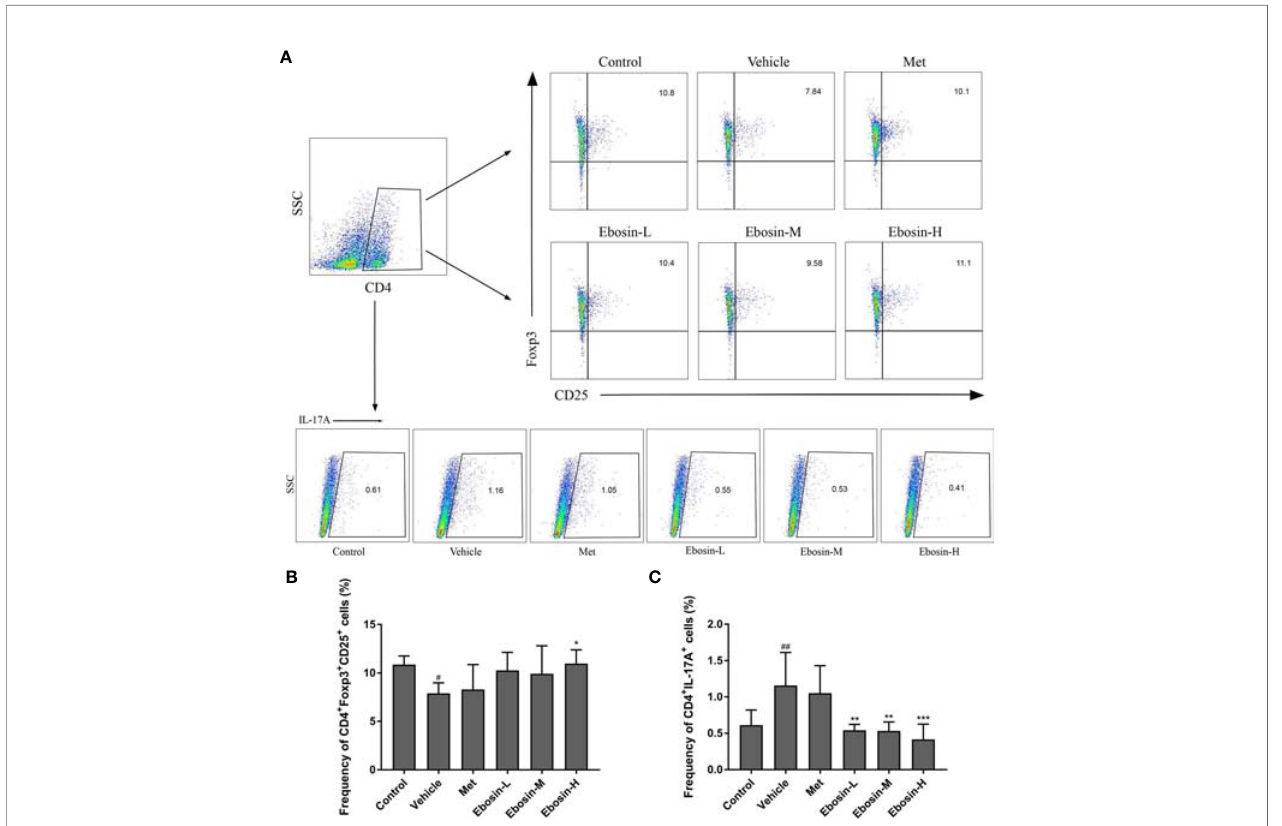
FIGURE 4 | Ebosin modulates CD4 + CD25 + Foxp3 + Tregs and CD4 + IL17A + Th17 cells in psoriatic mice. (A) Flow cytometric analysis of Treg and Th17 cells in spleen of each group. (B) The percentage of CD4 + CD25 + Foxp3 + Tregs in spleen. (C) The percentage of CD4 + IL17A + Th17 cells in spleen. All data were presented as mean ± SD; n = 6. # P < 0.05, ## P < 0.01 vs. control; * P < 0.05, **P < 0.01, ***P < 0.001 vs. IMQ-induced vehicle